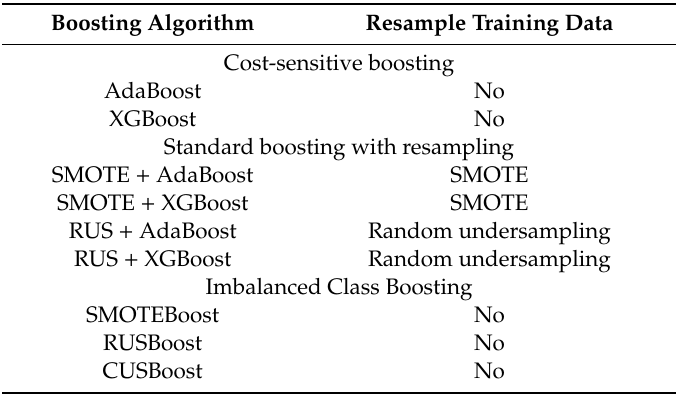
Table 1. Nine algorithms